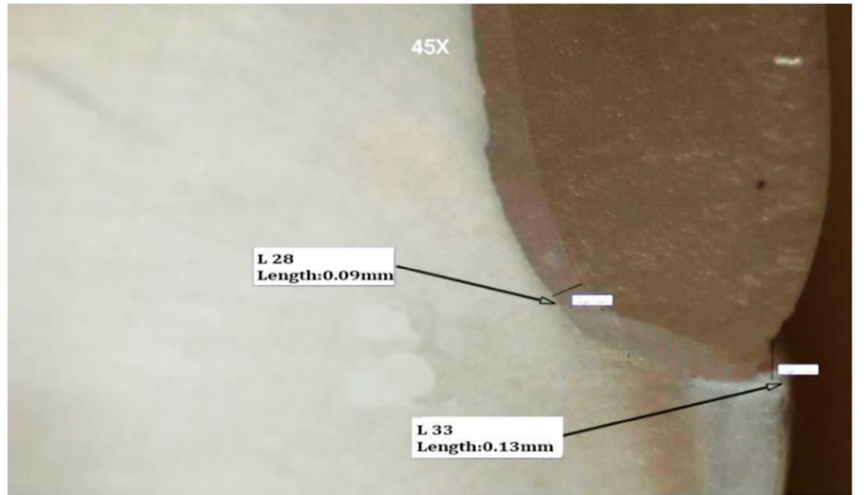
Figure 3. Stereomicroscopic view (45X) represents marginal and internal fit of a sectioned specimen at buccal margin and buccal finish line.